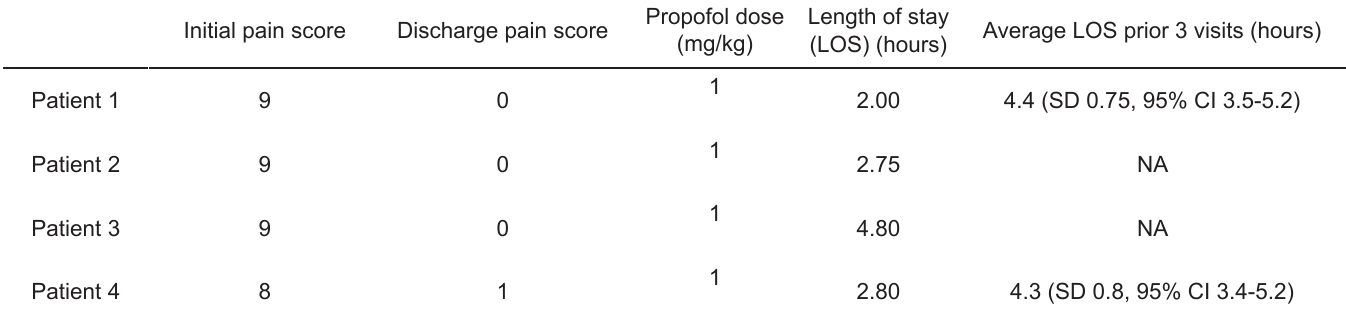
LOS, length of stay; SD, standard deviation; CI, confidence interval, NA, not